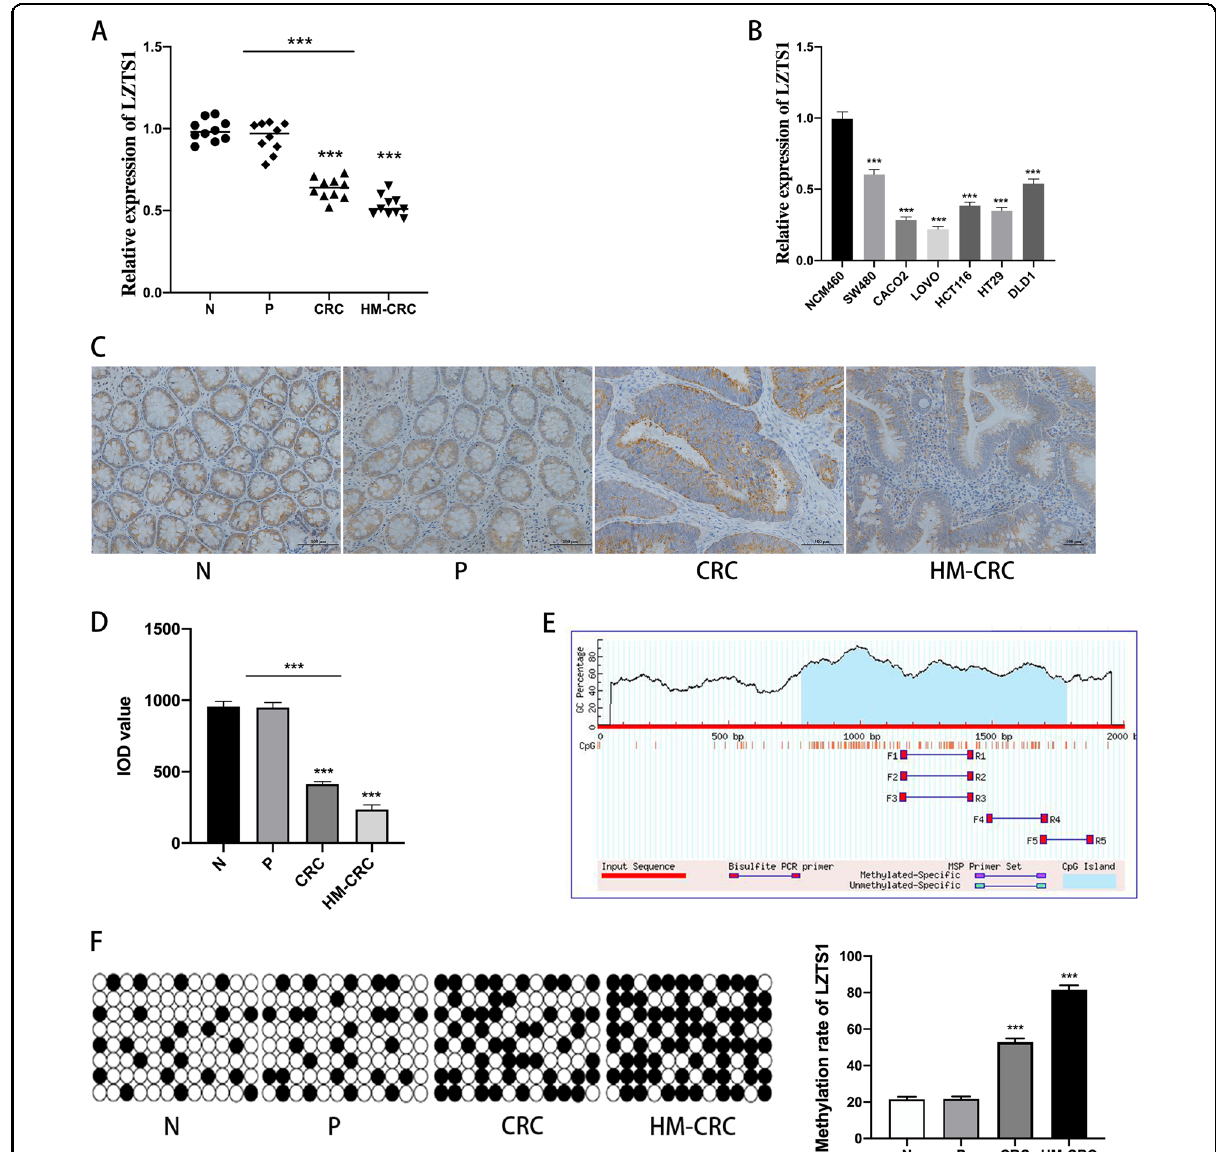
Fig. 1 LZTS1 expression level was negatively correlated with CRC metastasis. A Relative expression of LZTS1 in the 40 tissues (normal intestinal epithelial tissues(N), non-metastatic paraneoplastic intestinal epithelial tissues(P), non-metastatic primary CRC tumor tissues(CRC) and primary tumor tissues with hepatic metastatic(HM-CRC),10 samples respectively) were assessed by qRT-PCR.. Statistical analysis was performed between group N and CRC,N and HM-CRC,N + P and CRC + HM-CRC groups. B The LZTS1 expression patterns in CRC cell lines and NCM460 cell lines were assessed by qRT- PCR. The LZTS1 expression level of NCM460 cells was used as a control. C Immunohistochemical assessment of LZTS1 expression in normal intestinal epithelial tissues(N), non-metastatic paraneoplastic intestinal epithelial tissues(P), non-metastatic primary tumor tissues(CRC) and primary tumor tissues with hepatic metastatic tissues(HM-CRC)(original magni fi cation × 200). D Integrated optical density (IOD) value of the immunohistochemical assessment in samples. LZTS1 was down expressed in CRC samples and much more down expressed in HM-CRC samples compared with N samples. Statistical analysis was performed between group N and CRC, N and HM-CRC, N + P and CRC + HM-CRC groups. E The methylated CpG islands in the LZTS1 promoter region predicted by MethPrimer. F The methylation level of LZTS1 in four sample groups was detected by heavy sul fi te sequencing and the methylation rate in the HM-CRC group was much higher than the other three groups. N group was used as a control. * P < 0.05; ** P < 0.01; *** P <